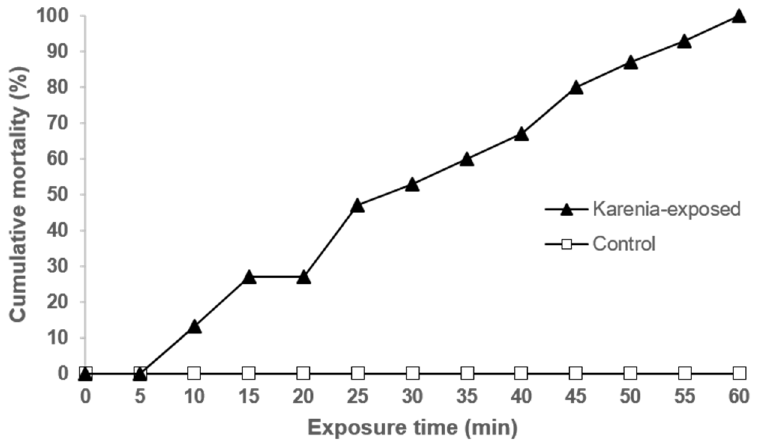
Figure 1. Percentage of cumulative mortality of medaka exposed to Karenia mikimotoi